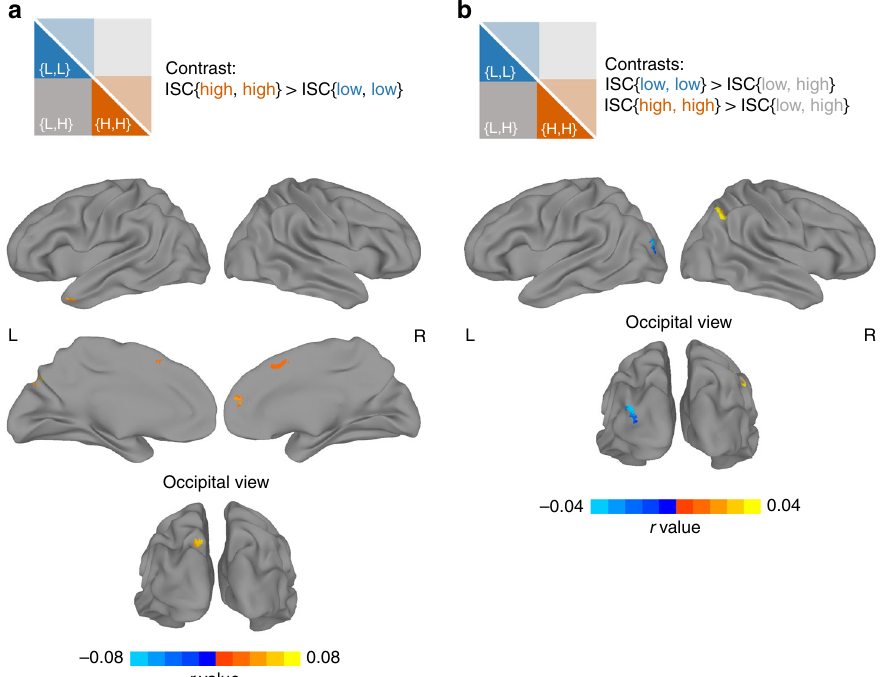
Fig. 3 Trait paranoia modulates patterns of inter-subject correlation during narrative listening. a Results from a whole-brain, voxelwise contrast revealing brain regions that are more synchronized between pairs of high-paranoia participants than pairs of low-paranoia participants (contrast schematized in top panel, cf. Fig. 1c). Signi fi cant clusters were detected in the left temporal pole, two regions in the right medial prefrontal cortex (one anterior and one dorsal and posterior), and the left precuneus. No clusters were detected in the opposite direction (low > high). b Results from two whole-brain, voxelwise contrasts revealing brain regions that are more synchronized within a paranoia group than across paranoia groups. The fi rst contrast (cool colors) revealed that left lateral occipital cortex was more synchronized within the low-paranoia group (i.e., low – low pairs) than across groups (i.e., high – low pairs; contrast schematized in top panel, cf. Fig. 1c). The second contrast (warm colors) revealed that right angular gyrus was more synchronized within the high-paranoia group (i.e., high – high pairs) than across groups. For all three contrasts, results are shown at an initial threshold of p < 0.002 with cluster correction corresponding to p <